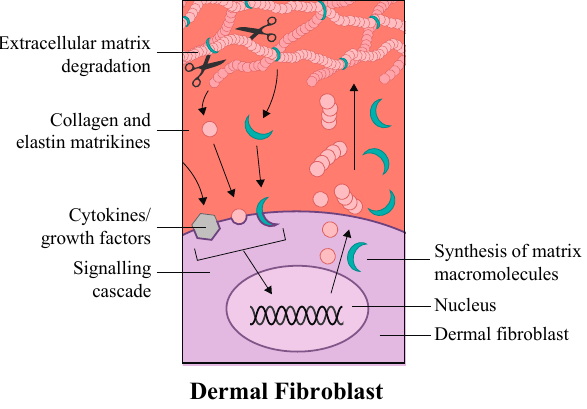
Figure 2. A Schematic representation of dermal fibroblast in regulation of skin homeostasis. Fibroblasts have been shown to influence the signaling pathways for the synthesis of extracellular matrix (ECM), collagen and growth factors.